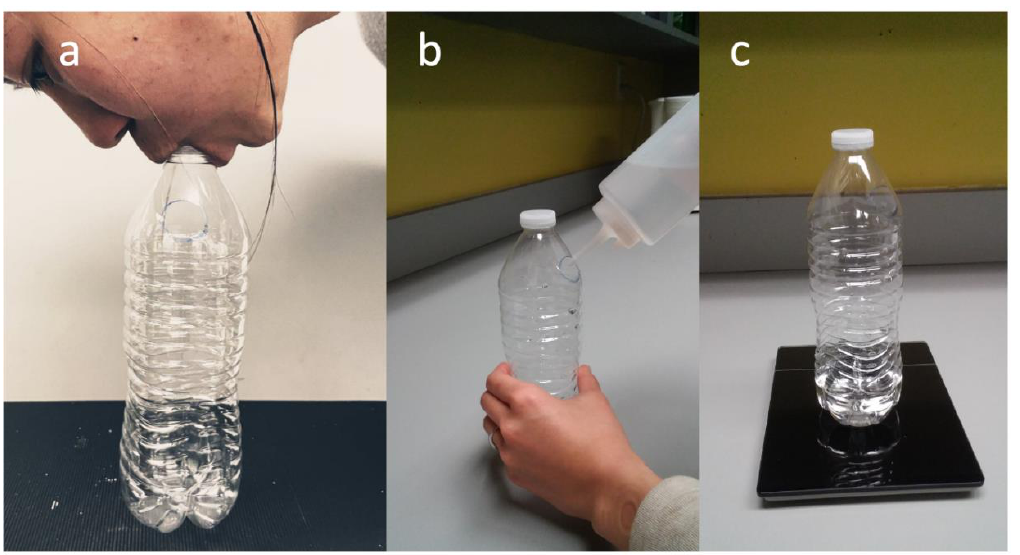
Figure 1. Measurements of lip grasping performance as the practical method; ( a ) pinch the top of a plastic water bottle, around the cap, using only his/her lips and without using their teeth, and lift the bottle about one inch above the table, and hold for a duration of two seconds before returning it to the table; ( b ) cut a one centimeter hole into the top of plastic bottle to easily and progressively add water to increase the weight; and ( c ) measuring the mass of the water bottle using a digital scale.